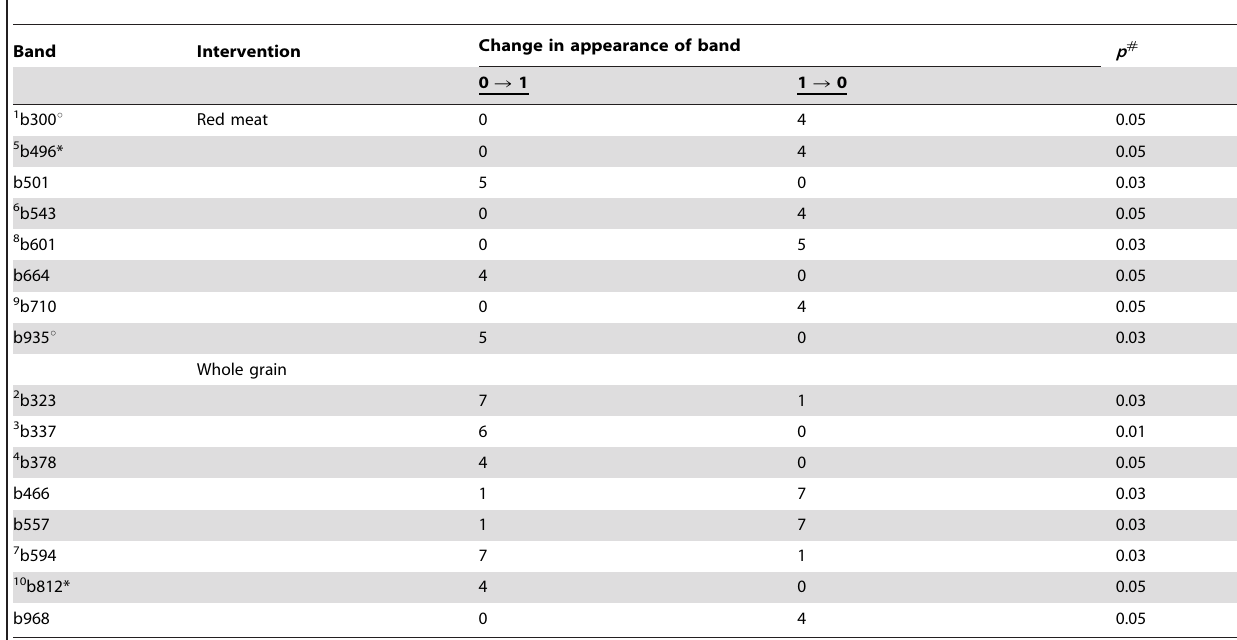
* Bands remained significant in multivariate logistic regression model with intervention as dependent variable and all changed bands as independent variables. u Change in microbiota only in group starting interventions with WG